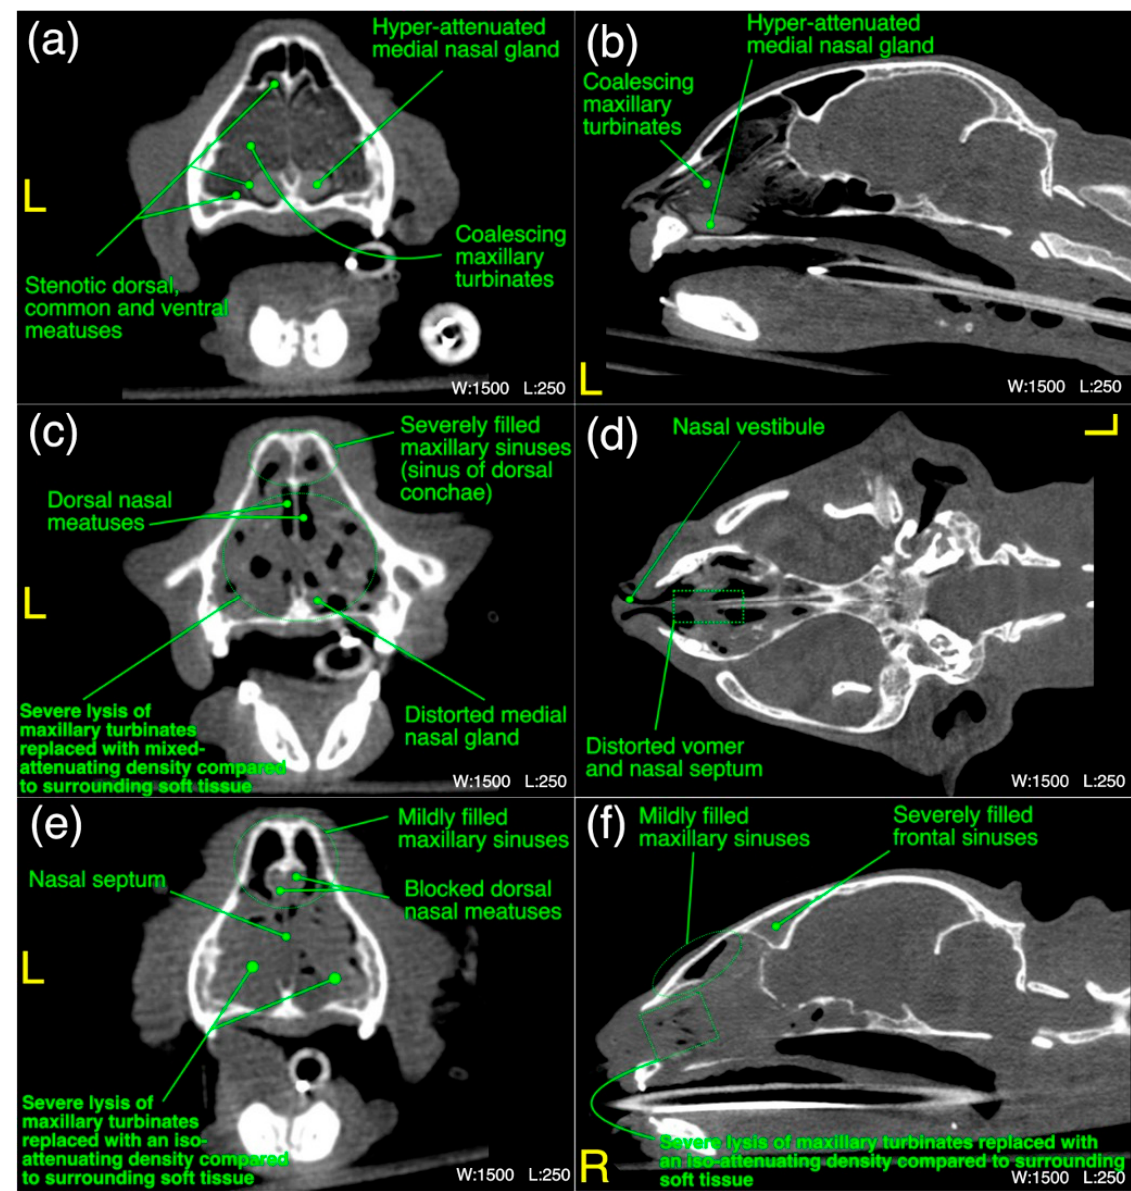
Figure 9. ( a – f ) A variety of computed tomographic changes of maxilloturbinate region are labeled for pathologies related to acute/chronic infectious respiratory disease signs in Cats 6, 10 and 21. Window, level and laterality are also labeled for each section.